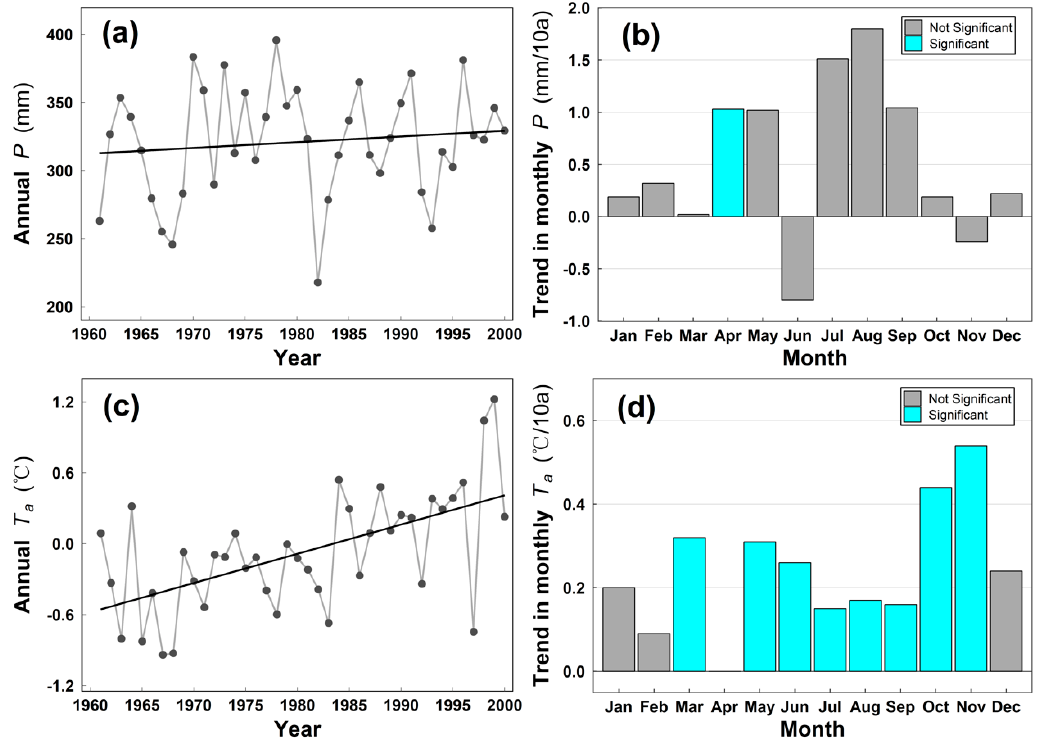
Figure 3. ( a , c ) are inter-annual variability precipitation (P) and temperature (Ta) with linear trend, respectively. ( b , d ) are bar plot of trends in monthly precipitation (P) and temperature (Ta) in the Yarlung Zangbo River basin, respectively. Bars in cyan bars represent significant trend ( p < 0.05) and gray bars not significant ( p > 0.1).